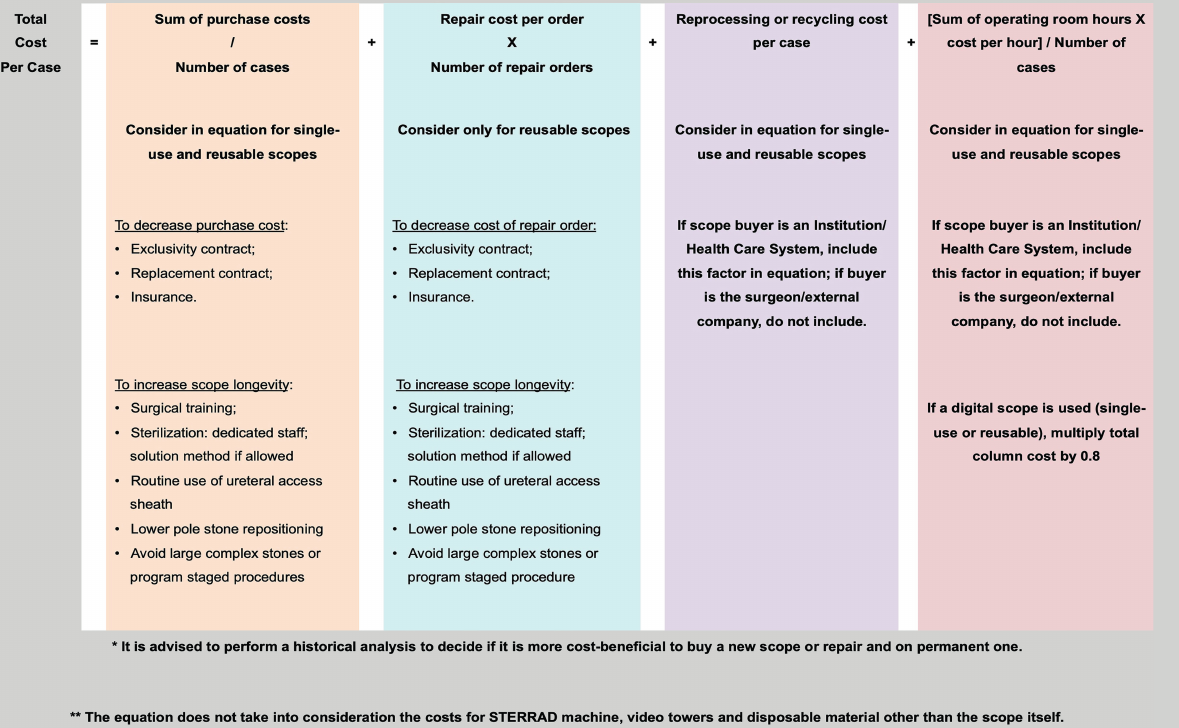
Figure 3 - Literature-based equation to allow a cost-analysis decision model to flexible ureteroscope